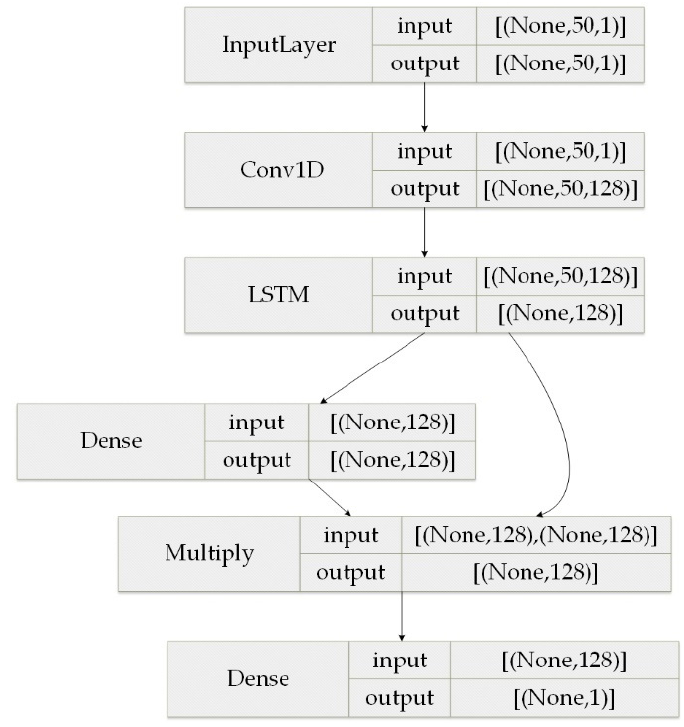
Figure 6. Model structure parameter configuration.